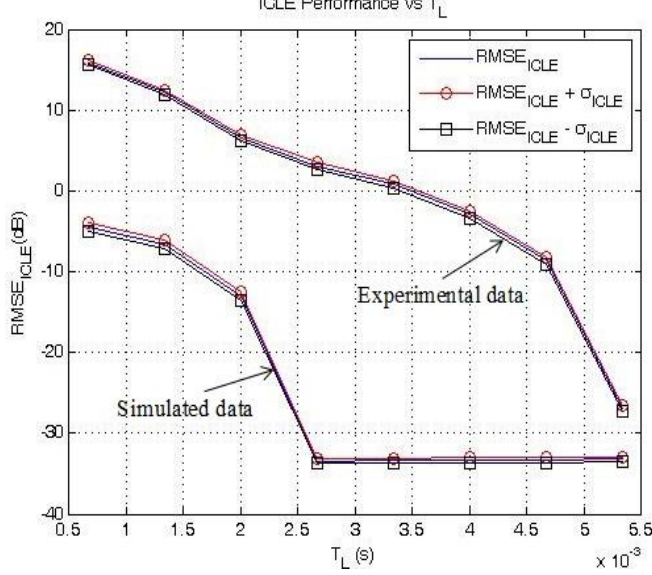
Figure 8. and as a function of T